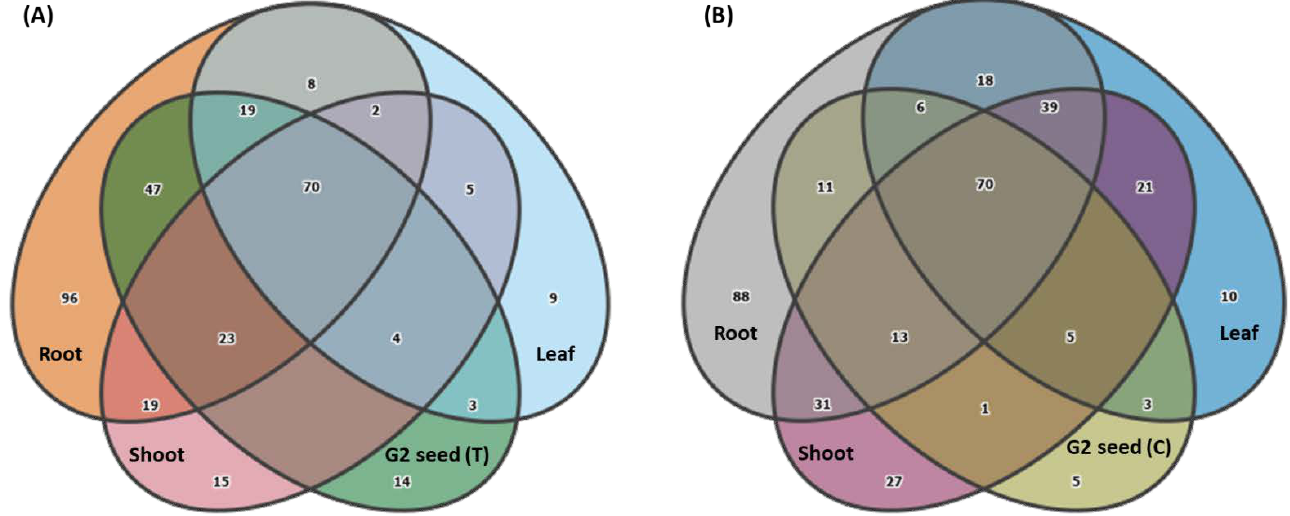
Figure 7. Venn diagrams showing the distribution of bacterial genera across G1 plant organs (root, shoot, leaf) and G2 seed for ( A ) Treatment G1 (T) and ( B ) Control, G1 (C) .